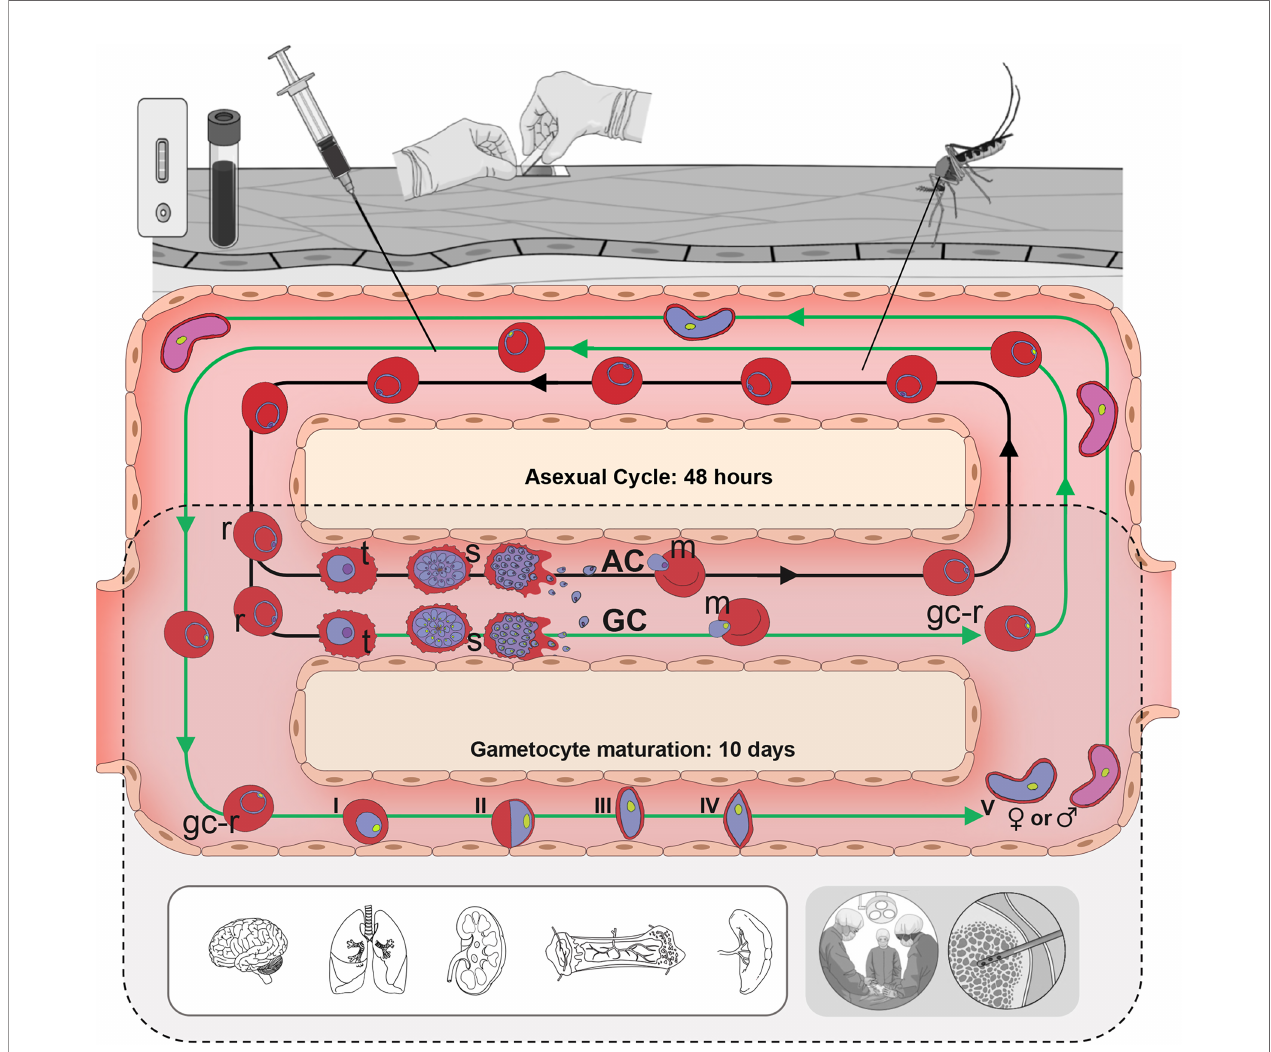
FIGURE 1 | Human Plasmodium falciparum life cycle. In the bloodstream, asexually-committed (AC) merozoites (m, purple nucleus) invade RBCs and begin the asexual replication cycle (black arrows), passing through ring (r), trophozoite (t) and schizont (s) stages. During this development some parasites become gametocyte-committed (GC, green arrows) producing gametocyte-committed merozoites (green nucleus). Gc-merozoites invade RBCs and begin differentiating through 5 morphologically distinct stages (I-V) over the next 10 days to become mature stage V gametocytes. P. falciparum trophozoites, schizonts and immature stage I – IV gametocytes sequester and cannot be detected in peripheral blood samples (grey shading). Therefore, a blood sample obtained by a syringe, fi nger prick or mosquito bite only contains ac- and gc-rings and stage V gametocytes, while tissue samples are needed to collect all developmental